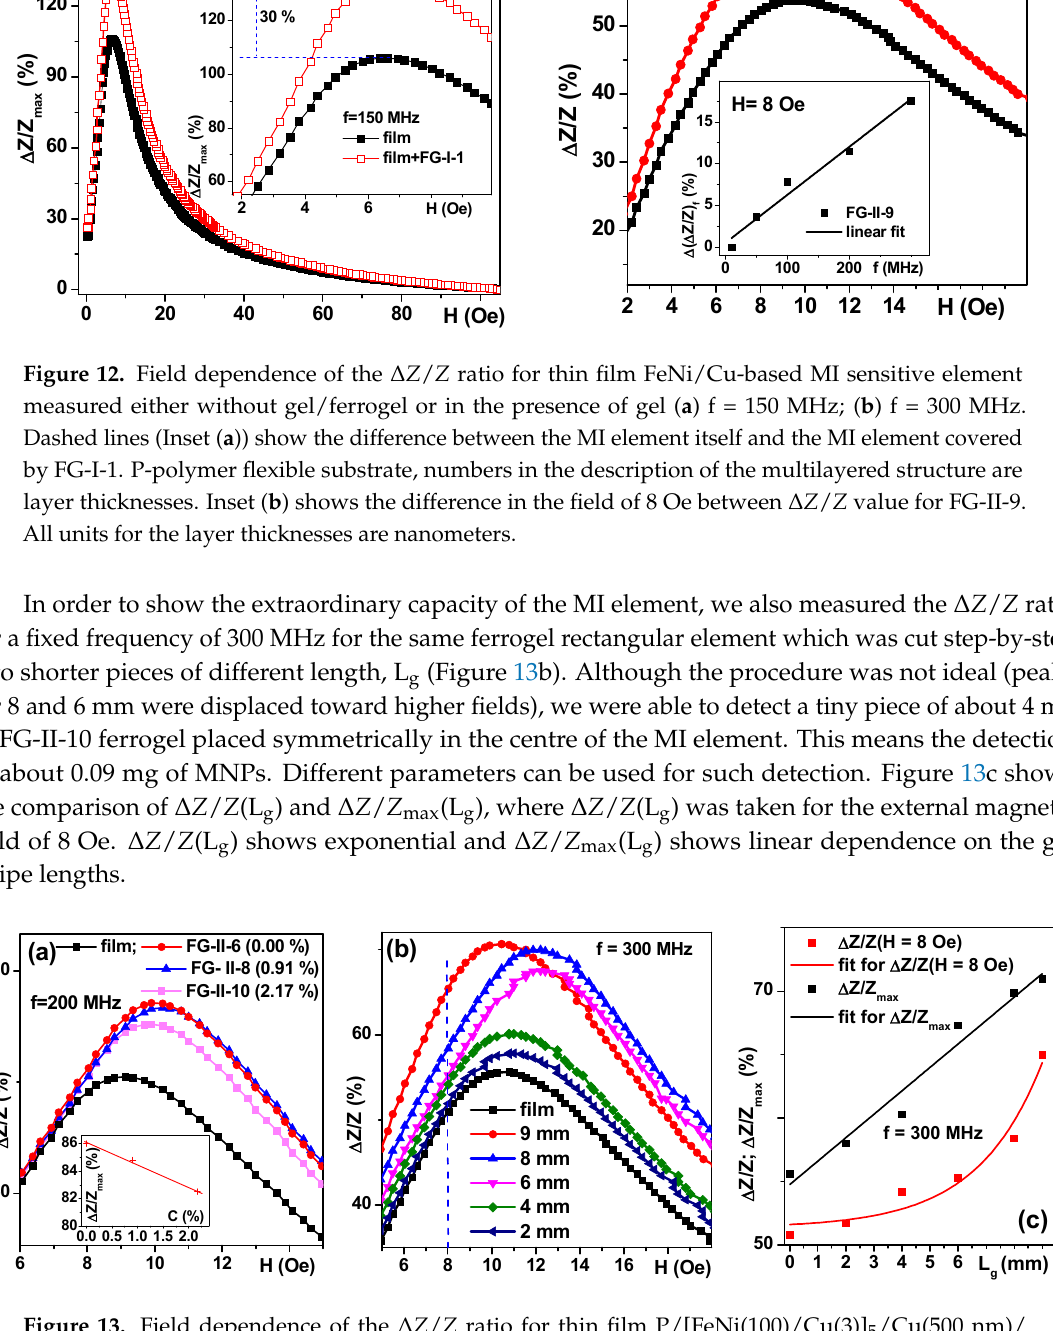
Figure 13. Field dependence of the Δ Z / Z ratio for thin film P/[FeNi(100)/Cu(3)] 5 /Cu(500 nm)/[FeNi(100)/Cu(3)] 5 . MI sensitive element measured either without gel/ferrogel or in the presence of gel and ferrogels ( a ) f = 200 MHz; ( b , c ) f = 300 MHz. Inset ( a ) shows the concentration dependence of Δ Z / Z ratio. Dashed line ( b ) shows the field of 8 Oe for which exponential dependence on the lengths of the gel sample was observed ( c ).